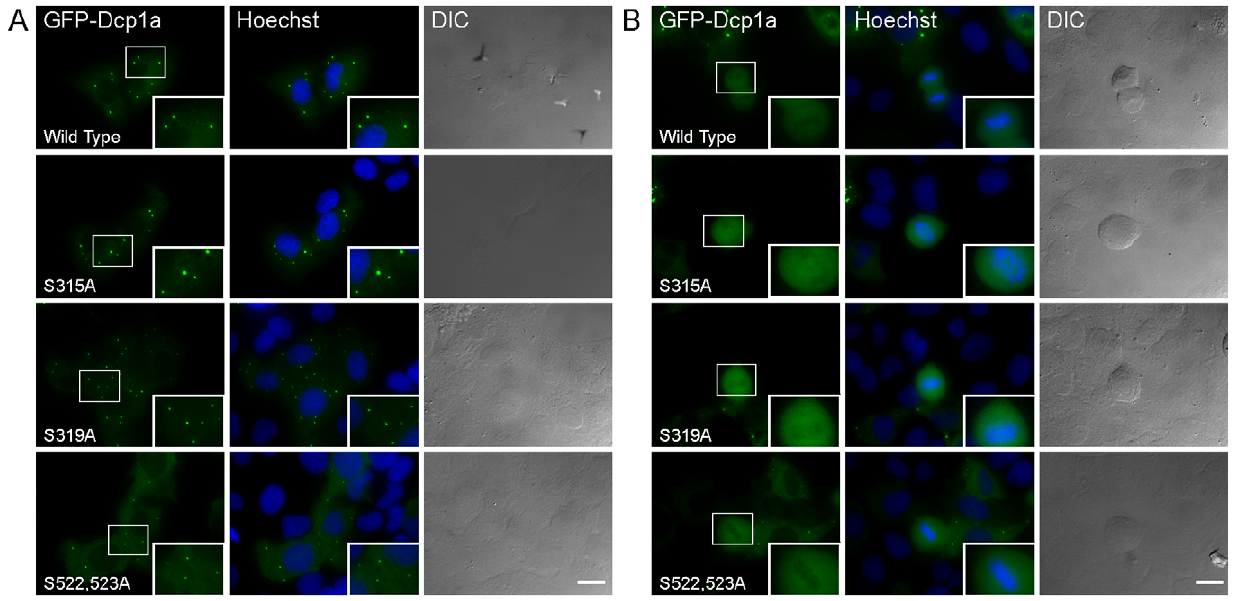
Figure 6. Serine mutated Dcp1a proteins assembled into PBs. (A) Serine to alanine mutated GFP-Dcp1a proteins assembled in PBs in U2OS cells, and (B) disassembled during mitosis. Enlarged insets are boxed. DNA was counterstained with Hoechst. (Bar 20 m m).